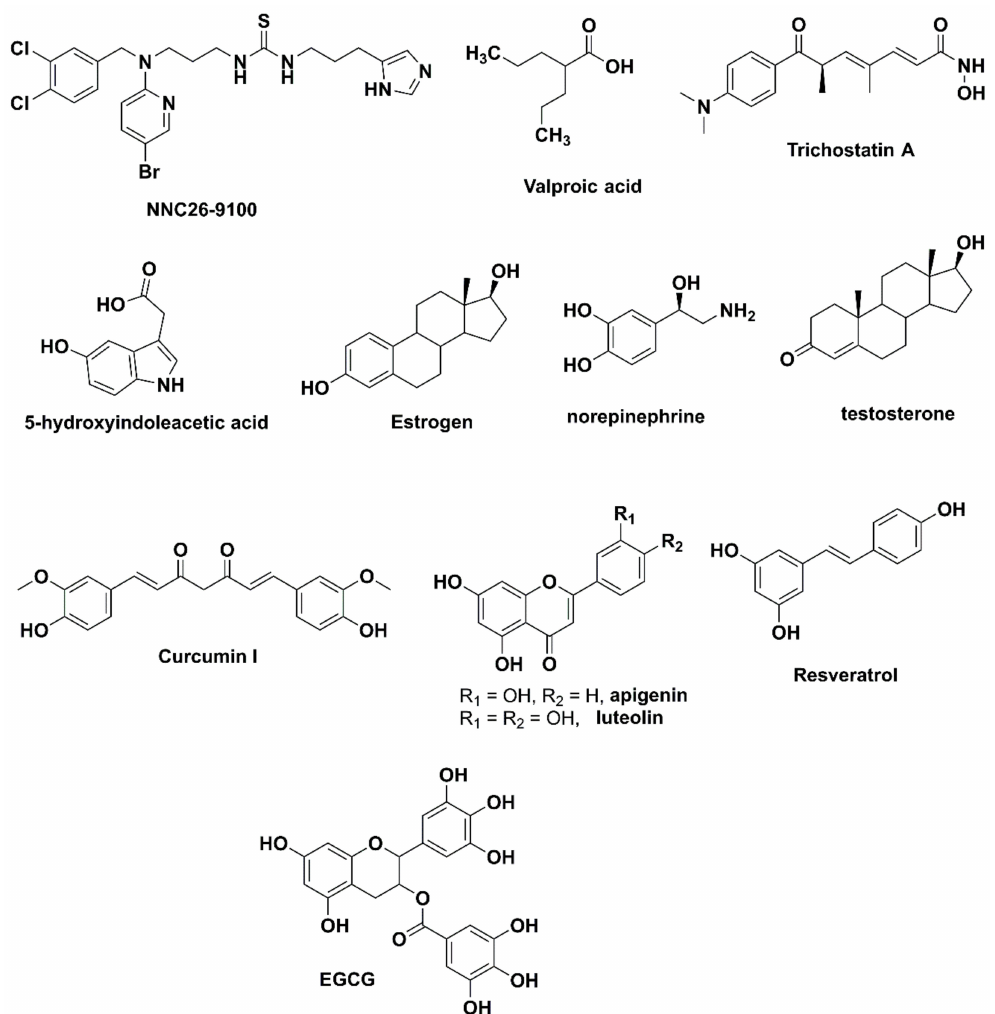
Figure 1. The structural variation of molecules studied as NEP